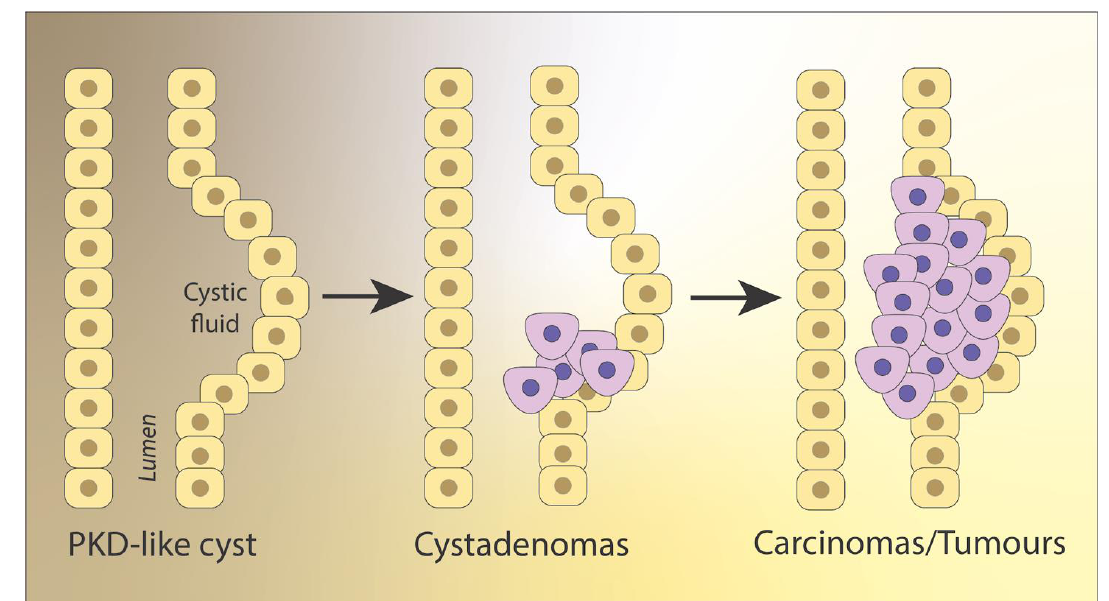
Figure 1. RCC progression. In many cases, clear cell renal cell carcinoma (ccRCC) begins as PKD-like cysts in the renal tubules that progress into cystadenomas, and malignant and invasive tumors. Adapted from [46].